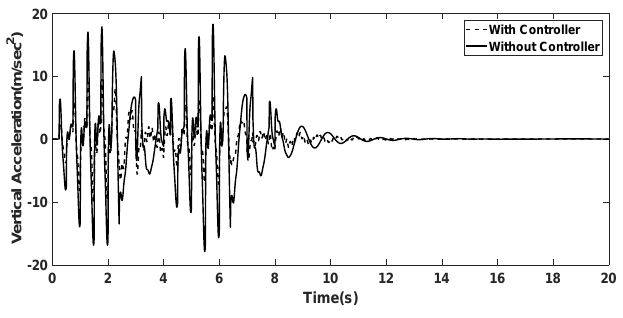
Figure 11. Vertical Acceleration.